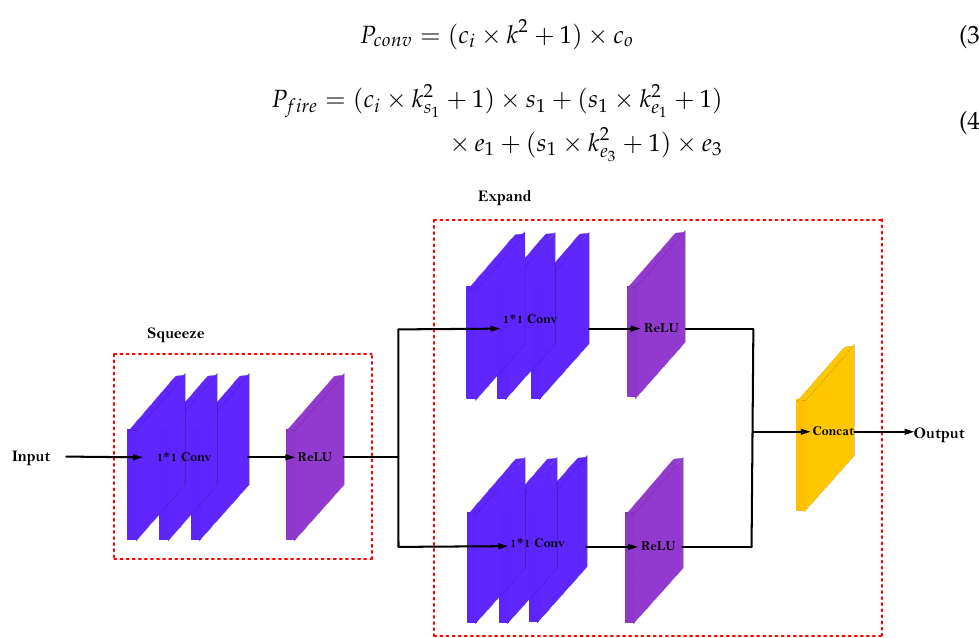
Figure 5. The structure of Fire Module. It is made up of two layers: squeeze and expand. The squeeze layer consists of a small number 1 × 1 filters, and the expand layer consists of a small number of 3 × 3 and 1 × 1